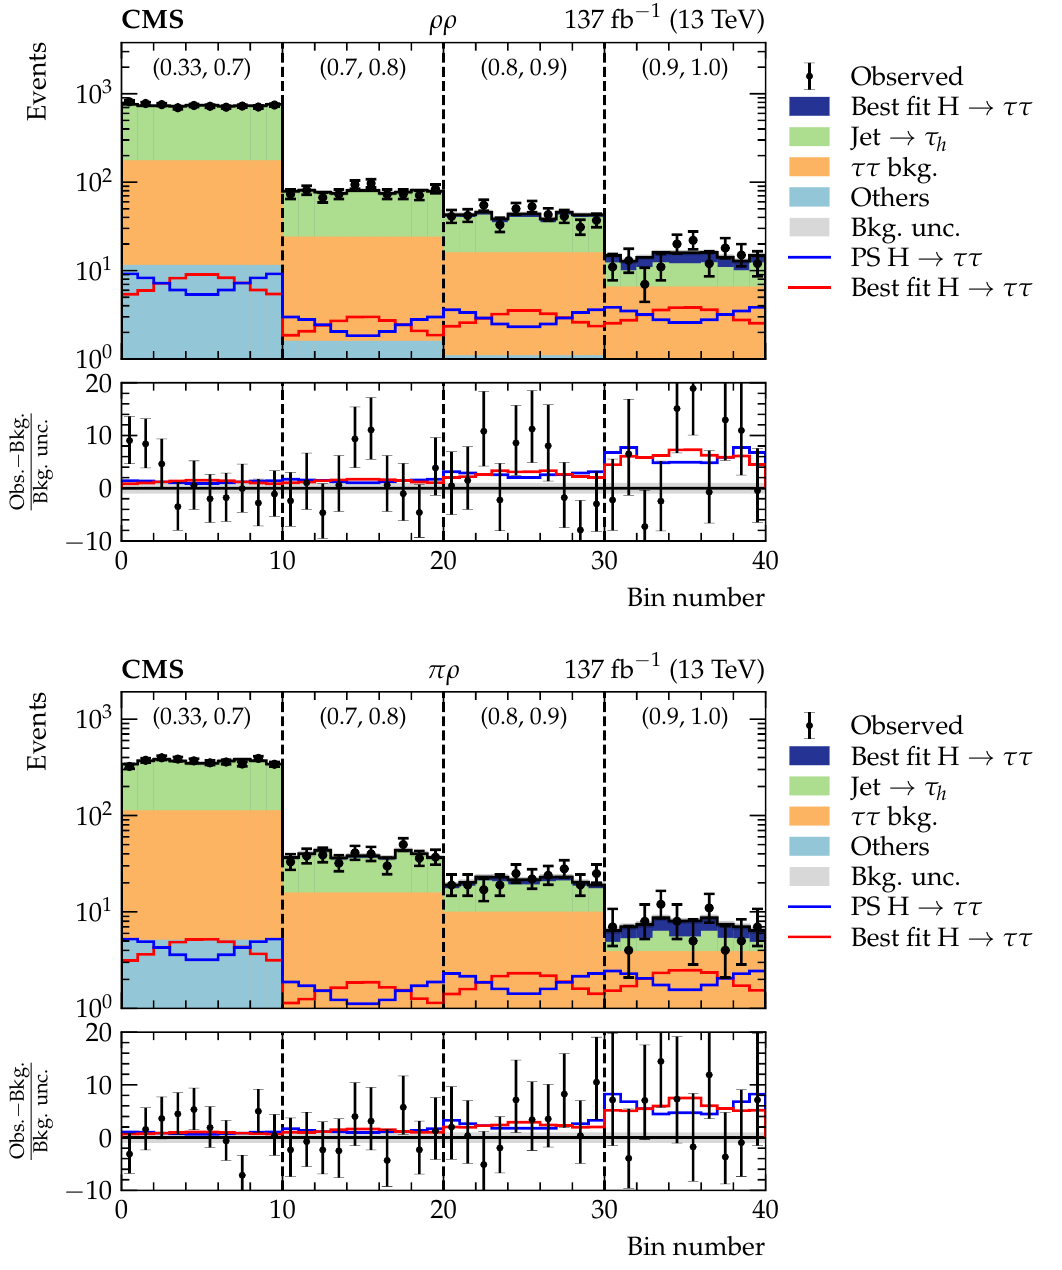
in the rr (upper) and pr (lower) channels in windows of increasing Figure 9 . Distributions of φ CP MVA score, shown on top of each window. The best fit and pseudoscalar (PS) signal distributions are overlaid, where in both cases the signal cross sections are set to the values obtained from the fit to data, which are given in section 12.1. The x -axis represents the cyclic bins in φ in the CP range of (0 , 360 ◦ ) . In the lower panels, the data minus the background template divided by the uncertainty in the background template is displayed, as well as the signal distributions divided by the uncertainty in the background template. The uncertainty band accounts for all sources of systematic uncertainty in the background prediction, after the fit to